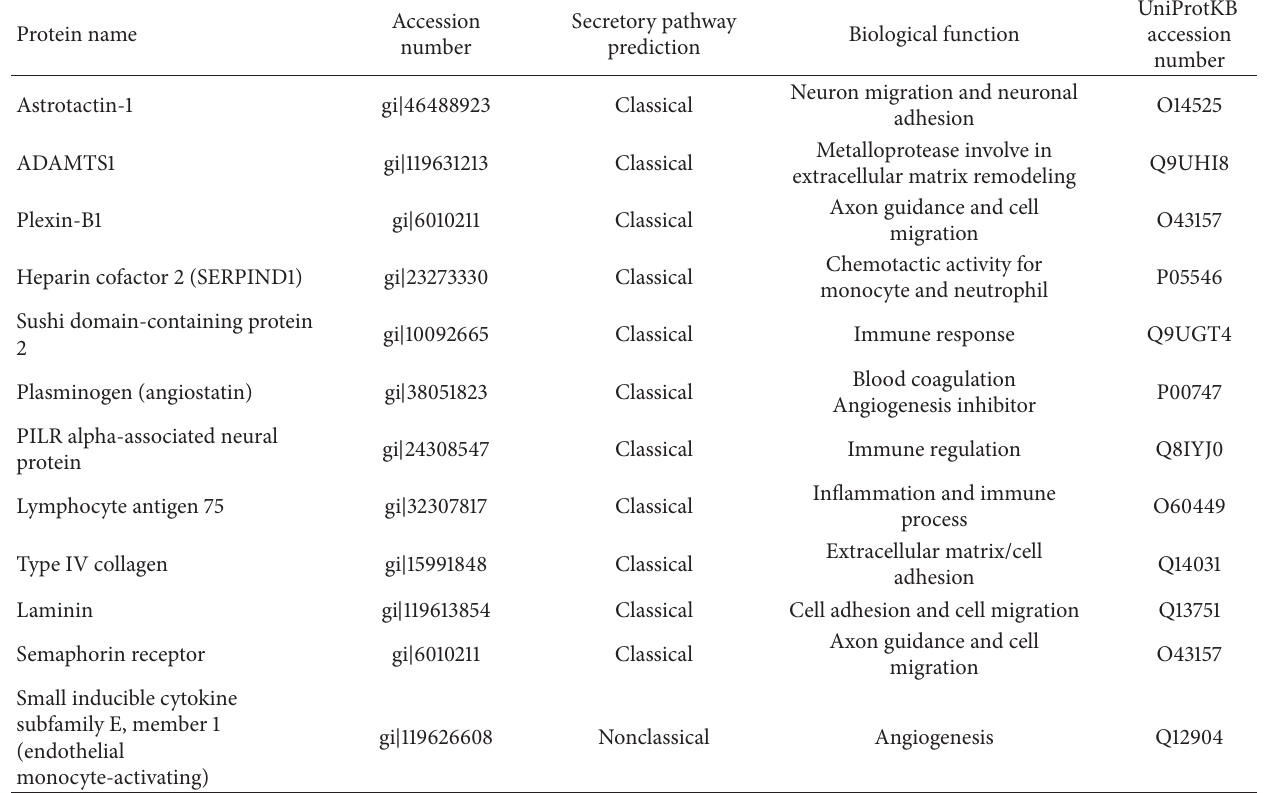
Table 1: List of EPC migratory enhancing factor candidates in PL-MSCs